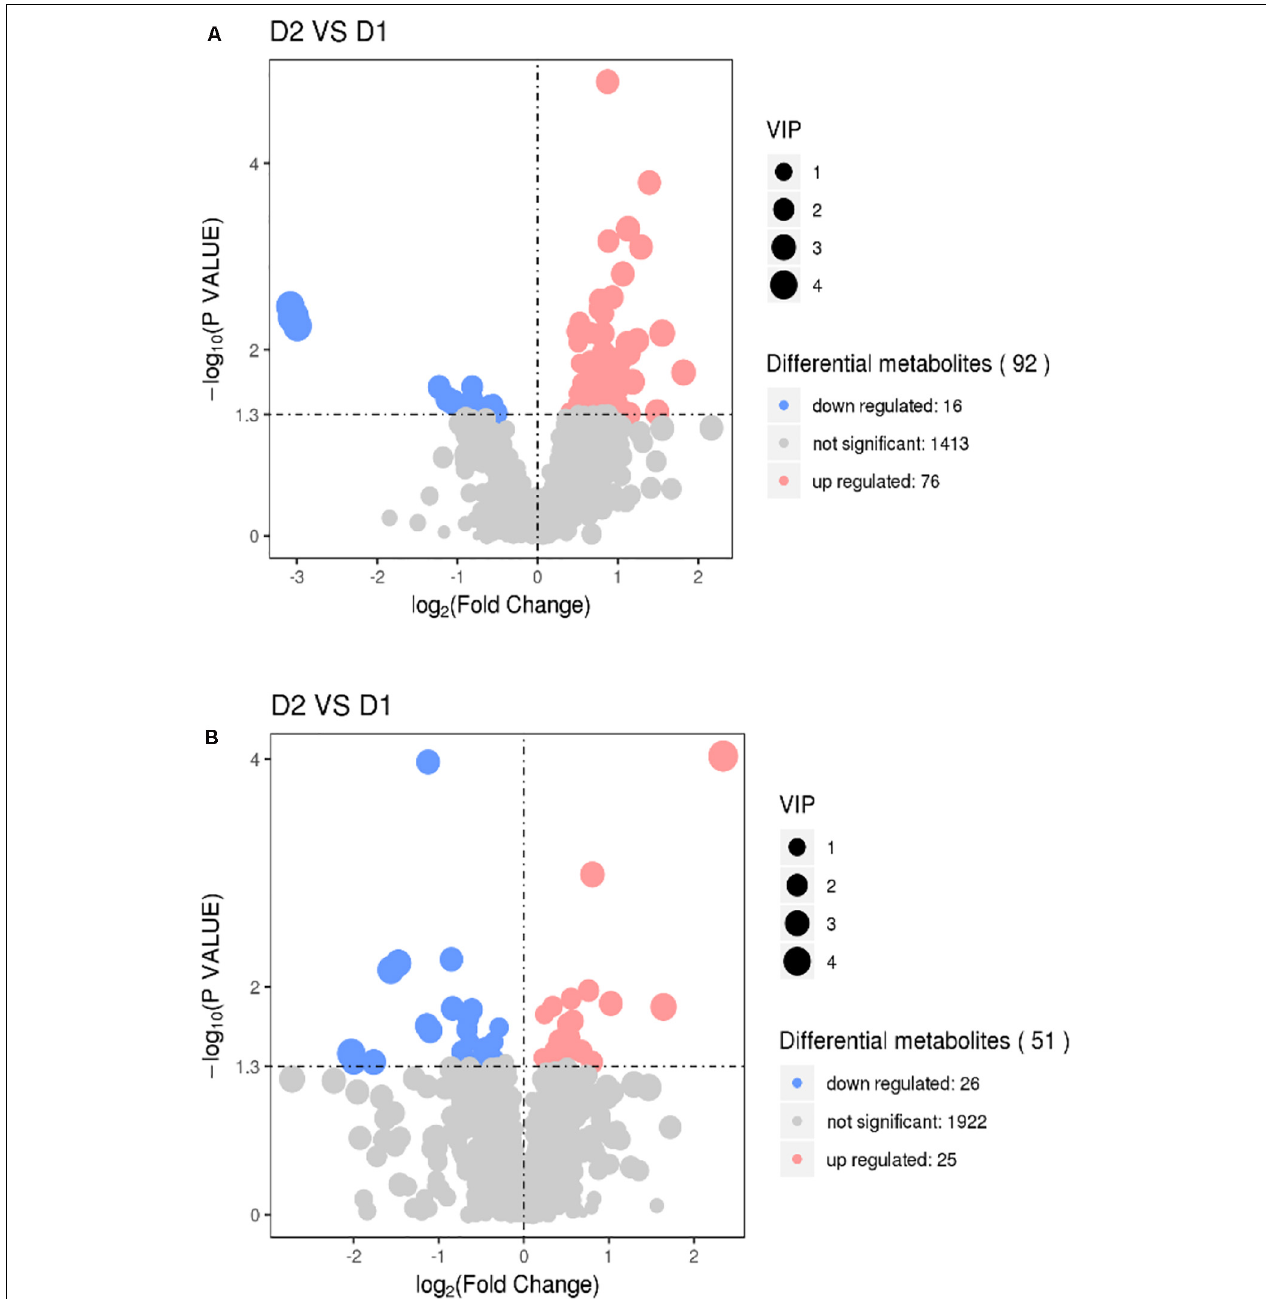
FIGURE 3 | Volcano plots for the potential differential metabolites in the liver of American eels of the HIS group in comparison with the control group under positive ion mode (A) and negative ion mode (B) . The point size represents the VIP value of the PLS-DA. Pink points indicate significantly upregulated metabolites, and blue points indicate significantly downregulated metabolites. D 1 = control group, D 2 = HIS